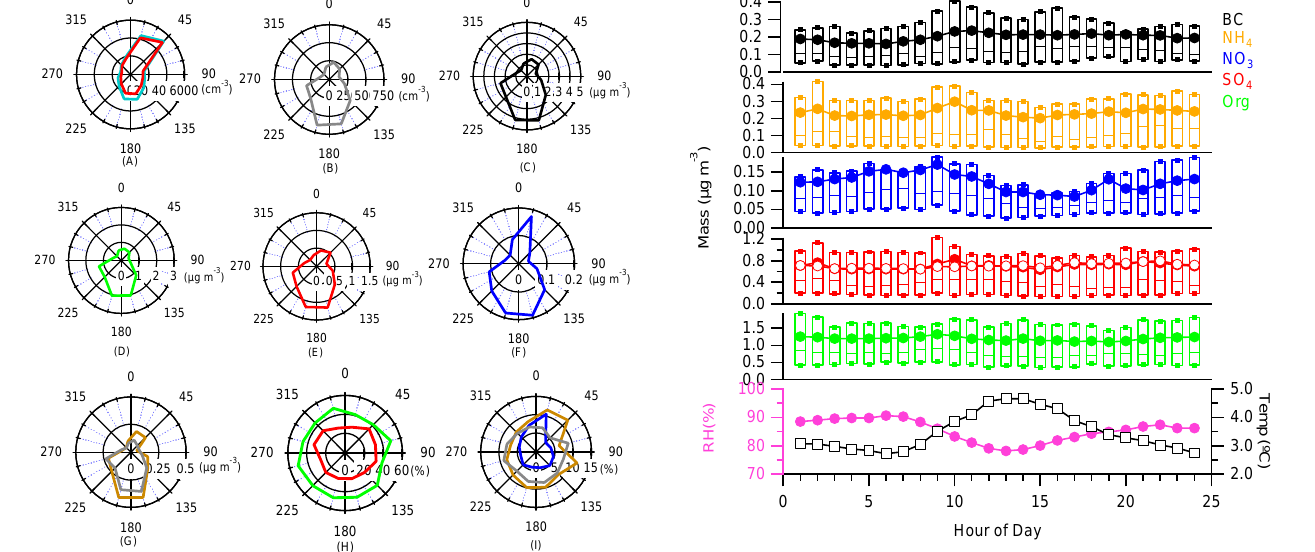
Figure 3. Wind roses for the campaign average. Aerosol number concentrations for (A) total (cyan) and in Aitken mode (red) and (B) in accumulation mode, mass concentrations for (C) PM 1 total and (D) organic, (E) sulfate, (F)nitrate, (G) ammonium (orange) and black carbon (grey), mass fractions to the total PM1 (%) of (H) sulfate (red), organic (green) and (I) nitrate (blue), ammonium (orange) and BC(grey).